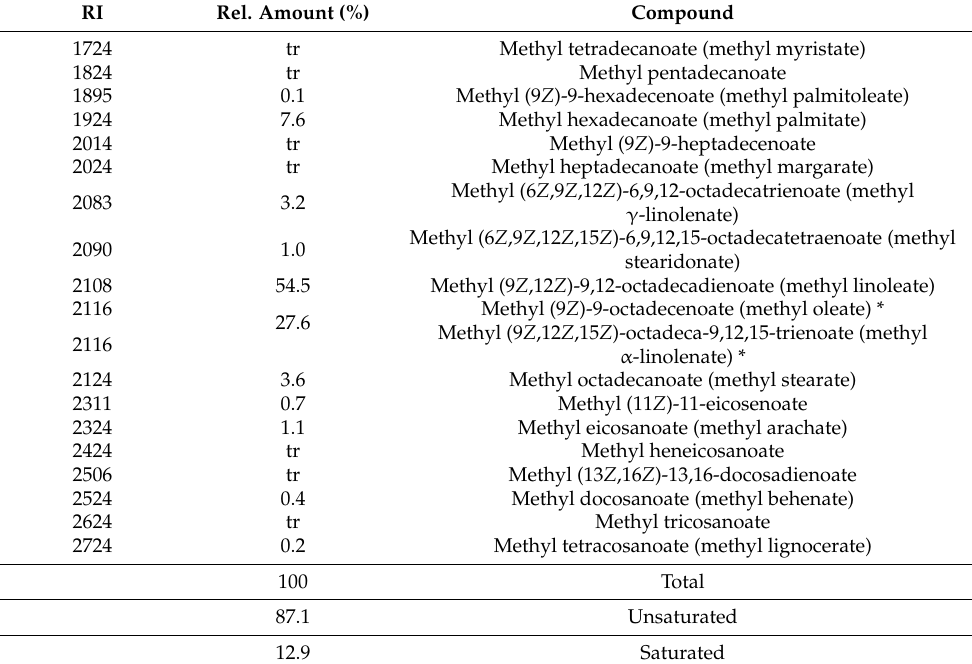
Table 2. The relative amounts of fatty acid methyl esters obtained by methanolysis of C. sativa seed oil. RI Rel. Amount